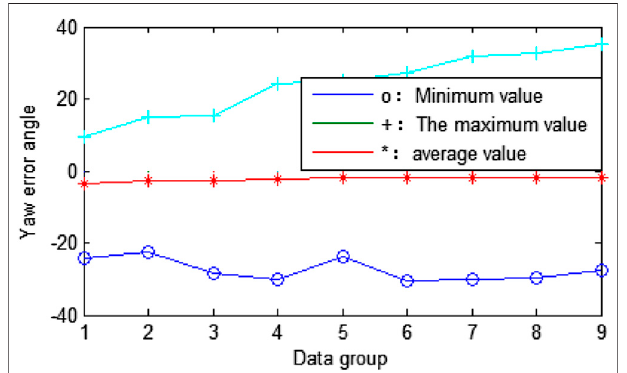
FIGURE 5 | The variation of the minimum, maximum and mean of the yaw error.